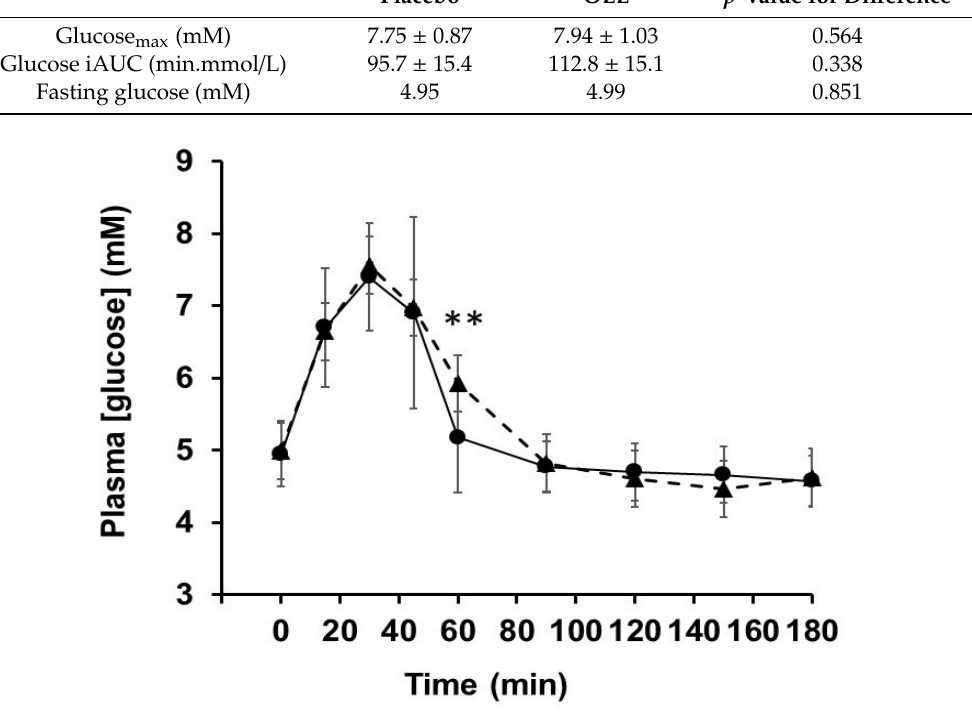
Figure 6. Post-prandial blood glucose concentrations. Blood glucose levels were measured in volunteers after consumption of sucrose solution following 1-week consumption of OLE ( ▲ ) or placebo (●). ** p < 0.01.